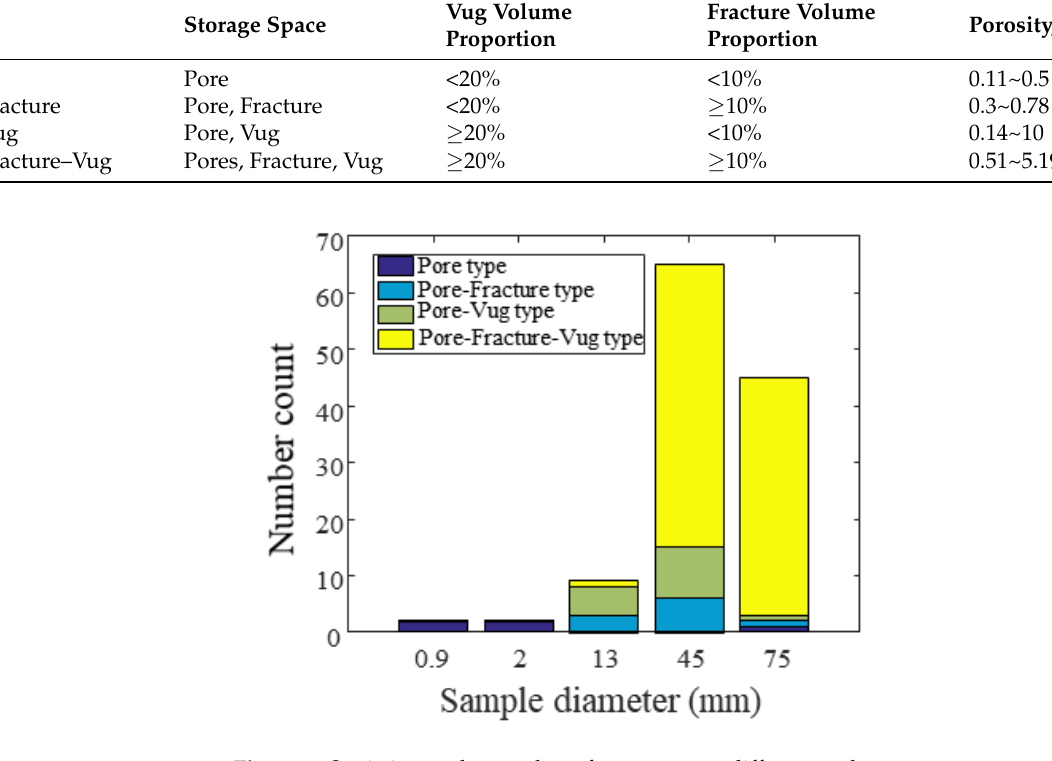
Figure 8. Statistics on the number of core types at different scales.